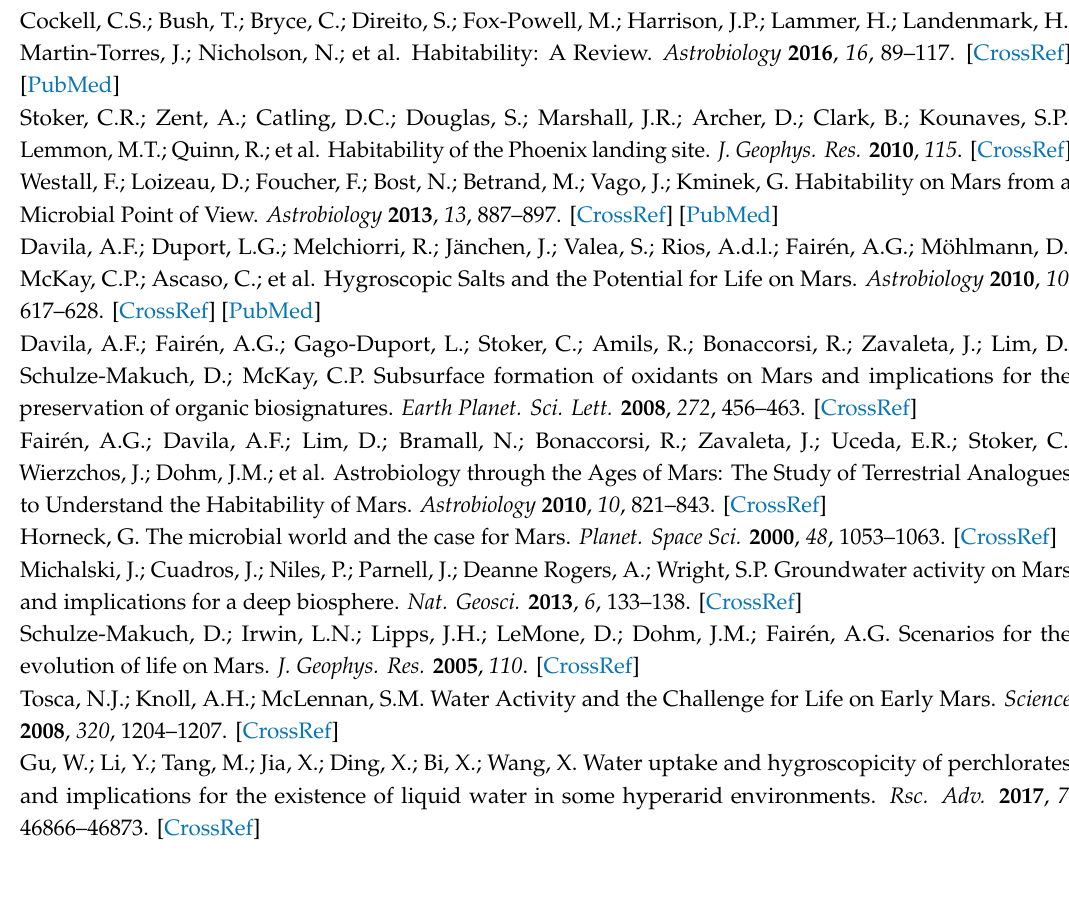
Table S1: List of antibodies printed in the LDChip168 for this study. Table S2: Working dilution and detection limit of Abs in